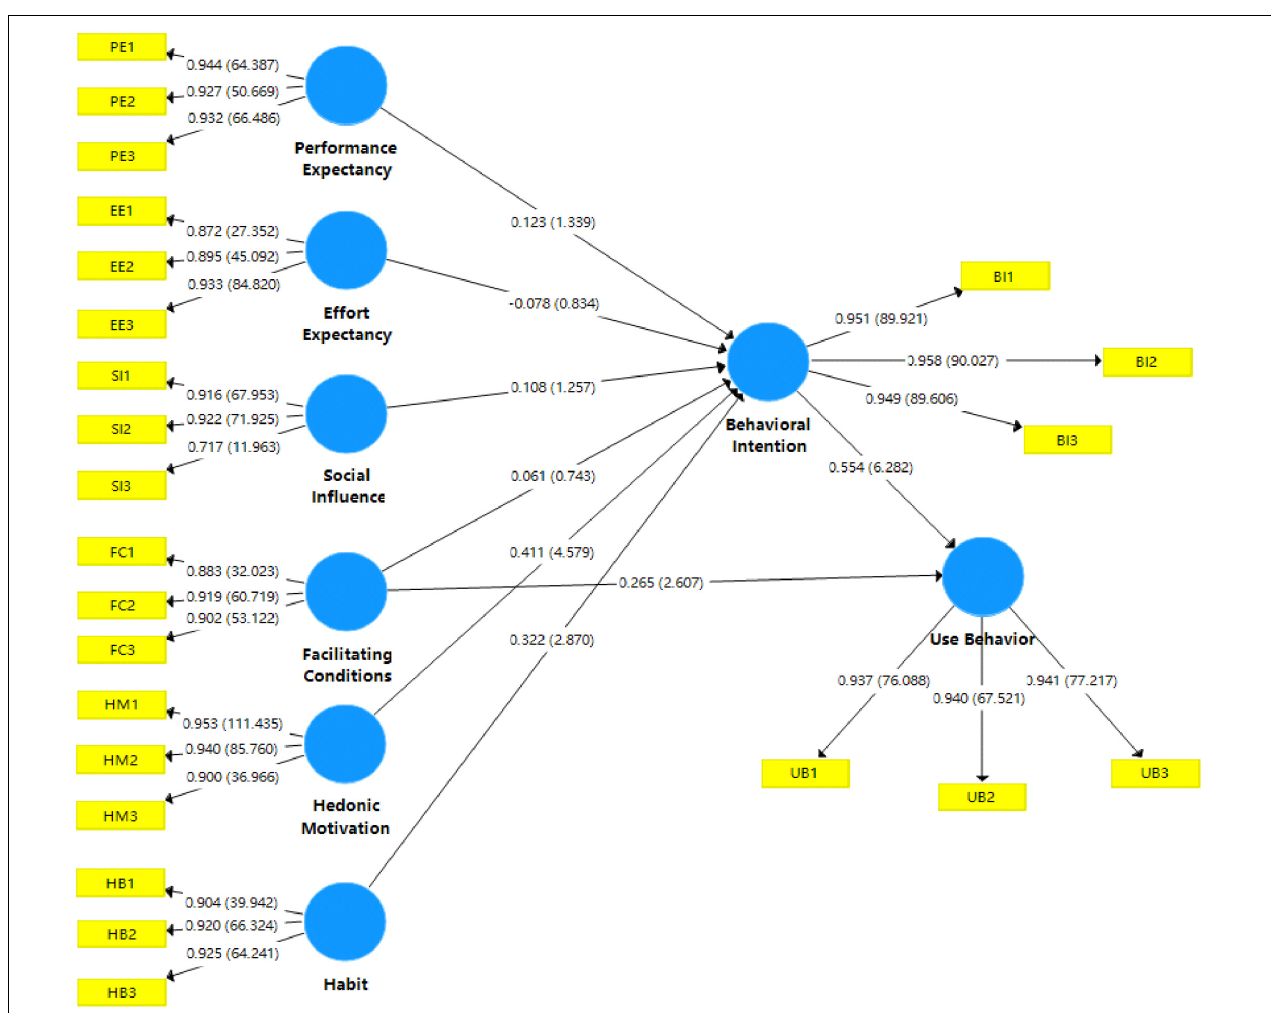
FIGURE 4 | The structural model with inner and outer